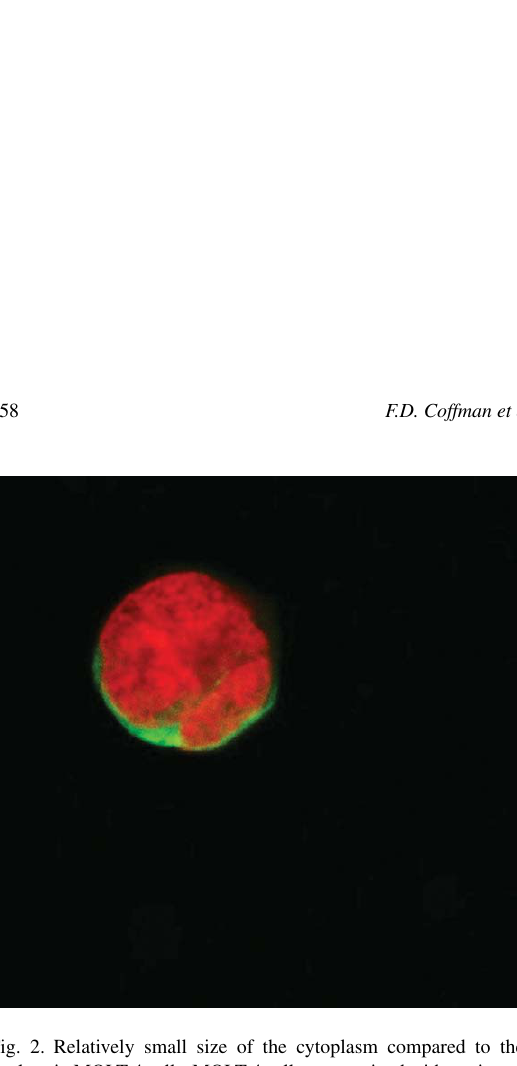
Fig. 2. Relatively small size of the cytoplasm compared to the nucleus in MOLT-4 cells. MOLT-4 cells were stained with a primary antibody recognizing the U1A ribonucleoprotein (which exists in both cytoplasmic and nuclear compartments) and a secondary anti- body conjugated to Alexa Fluor 488 (green fluorescence) before chromatin was stained with propidium iodide (red fluorescence). The volume of the cell is primarily taken up by the nucleus, leaving a thin green crescent of cytoplasm visible on one